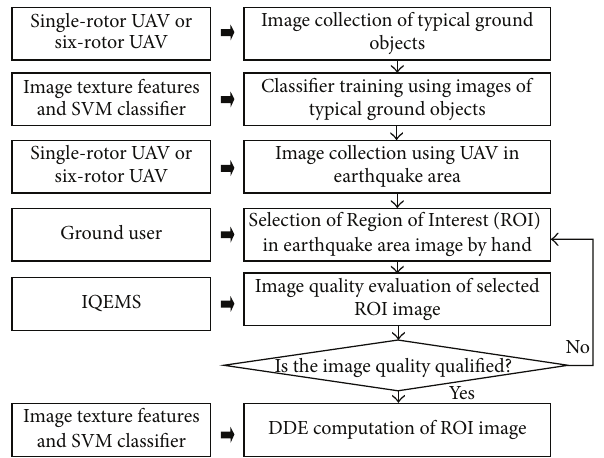
Figure 3: The computation flow chart of proposed